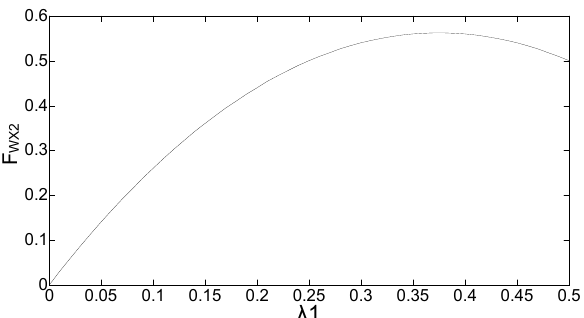
Figure 6. Diagram of the relationship between F W x2 W